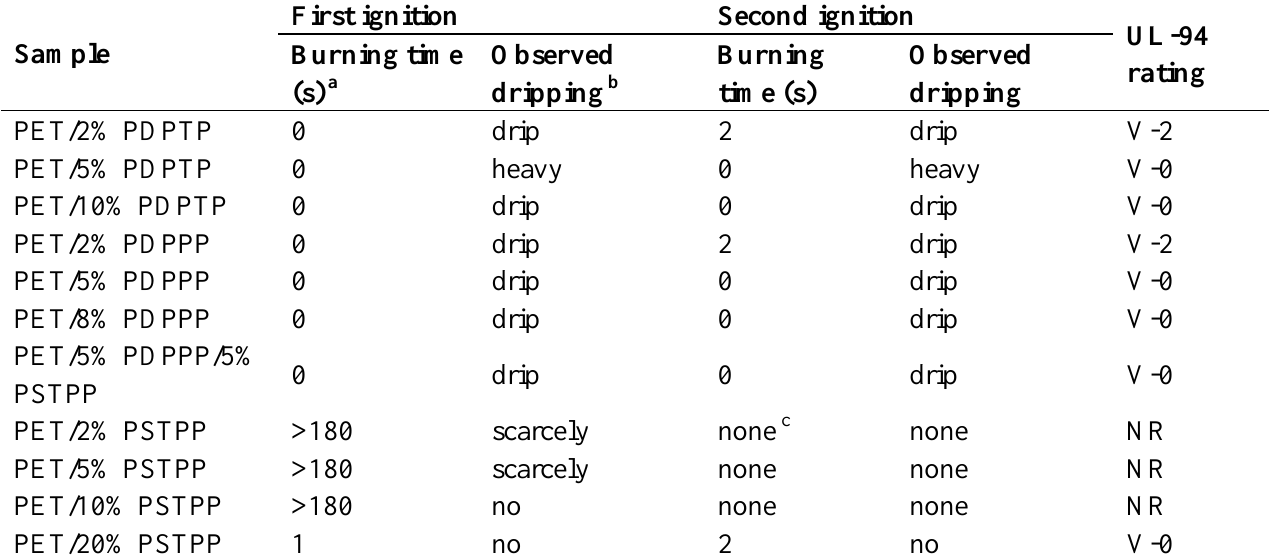
Table 6. Test results of flammability and melt-dripping behaviors of PET/ArPPN blends during the UL-94 test